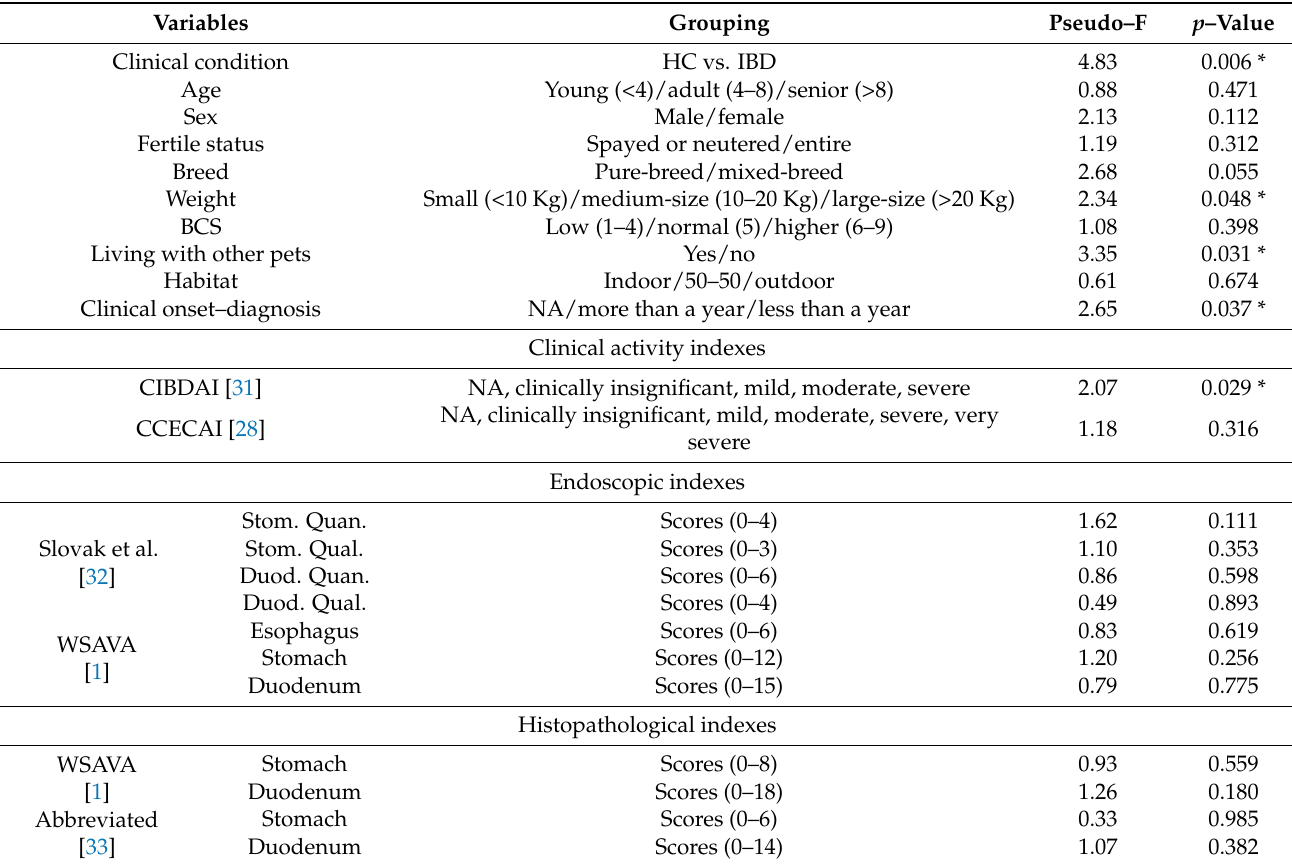
Table 6. Permutational multivariate analysis of variance (PERMANOVA) in bacterial compositions of fecal samples considering different